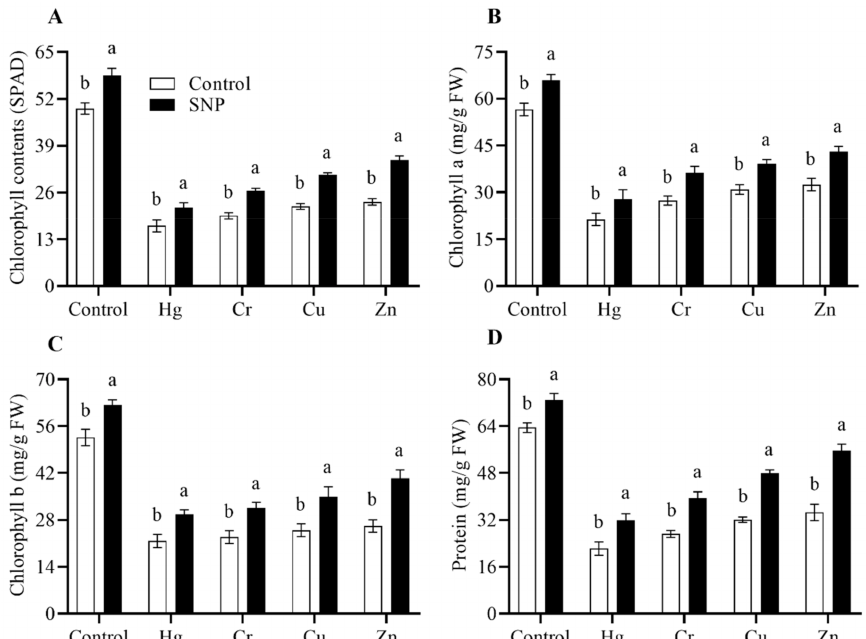
Figure 2. Effects of exogenously applied SNP on rice with or without Hg-, Cr-, Cu-, and Zn-induced stress on rice plants. ( A ) Chlorophyll (SPAD), ( B ) chlorophyll a content, ( C ) chlorophyll b content, and ( D ) protein content. Each data point indicates the mean ± standard deviation ( n = 3). Bars with different letters indicate significant differences, according to Duncan’s multiple range test. The results are compared to the respective controls (Hg-, Cr-, Cu-, and Zn-untreated and Hg-, Cr-, Cu-, and Zn-treated plants).